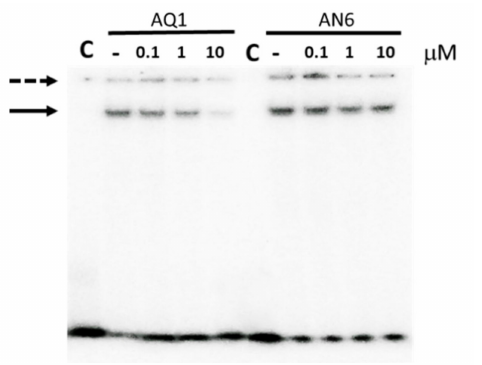
Figure 7. EMSA of 100 nM ds_kit*-SP1 (1:1 molar ratio) in the presence of increasing concentration of AQ1 or AN6. Lane C refers to samples in the absence of the protein; lanes labelled—refer to samples in the absence of ligand; solid arrows point to DNA-protein complexes, the dotted one to not solved high molecular weight